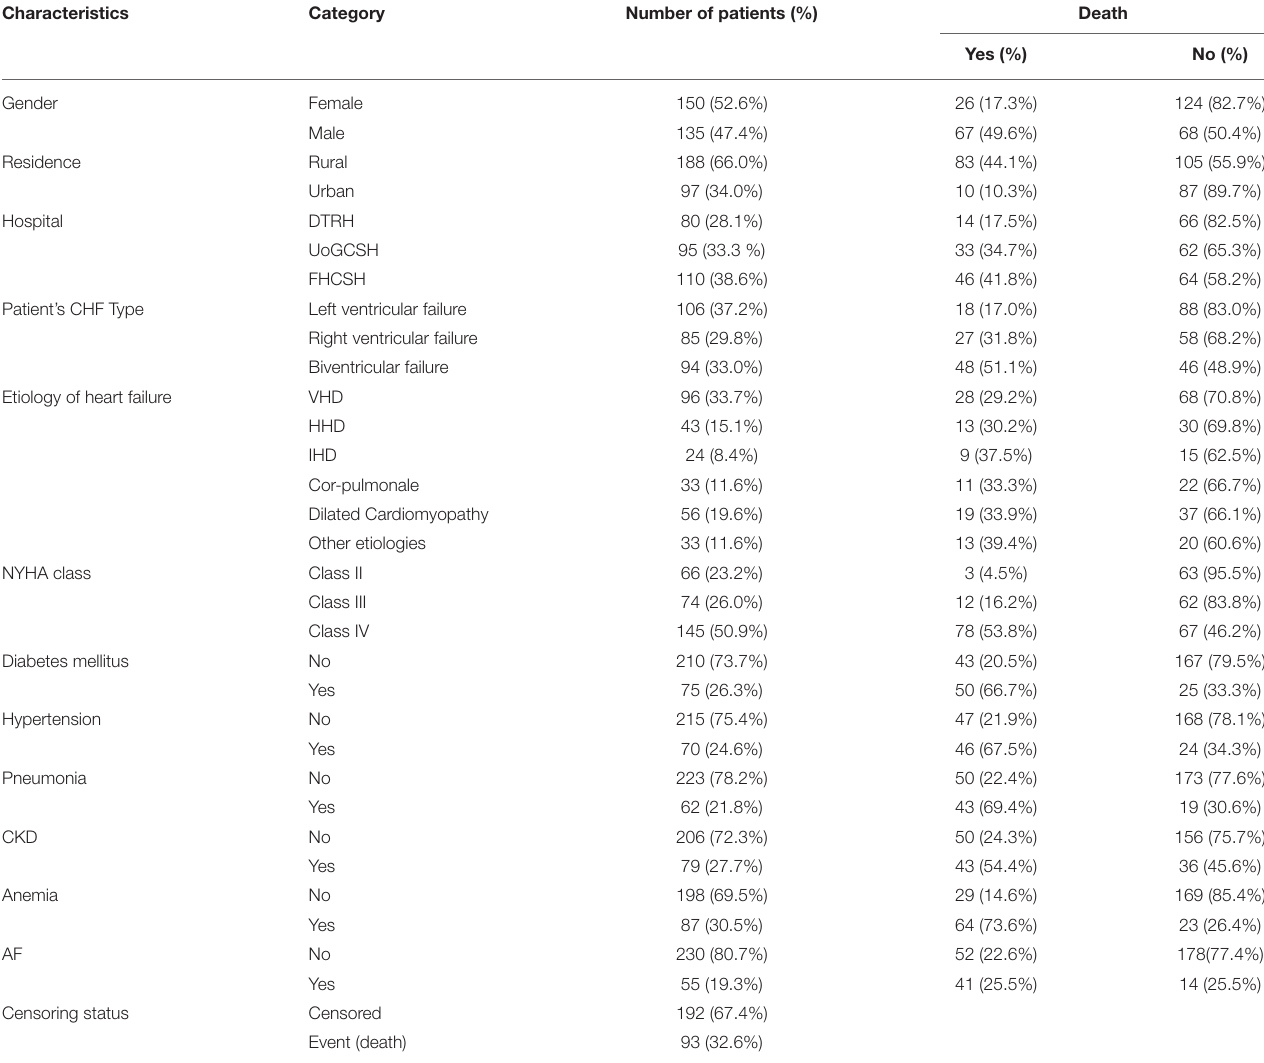
TABLE 1 | Results of descriptive measures of categorical variables of patient’s data with CHF taken at three hospitals from 2015 to 2020.